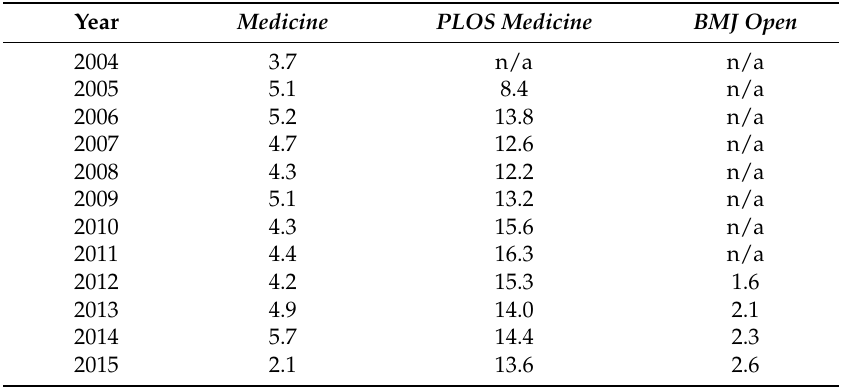
Table 4. Journal Impact Factors for Medicine , PLOS Medicine and BMJ